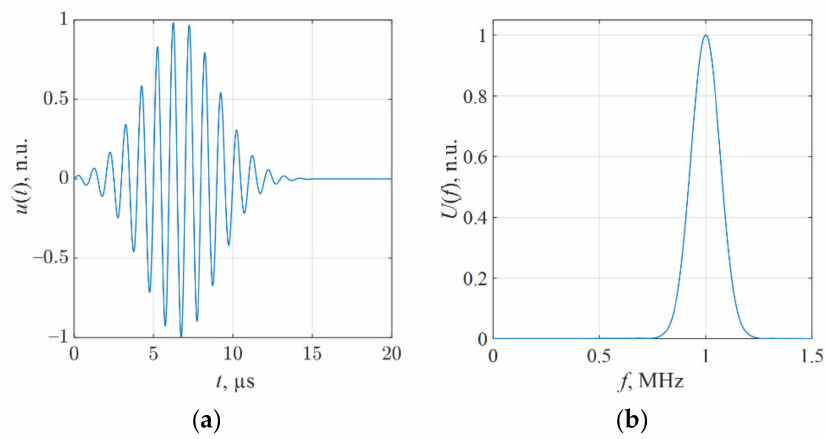
Figure 7. ( a ) Excitation signal waveform; ( b ) excitation signal spectrum. Selective Excitation of S 3